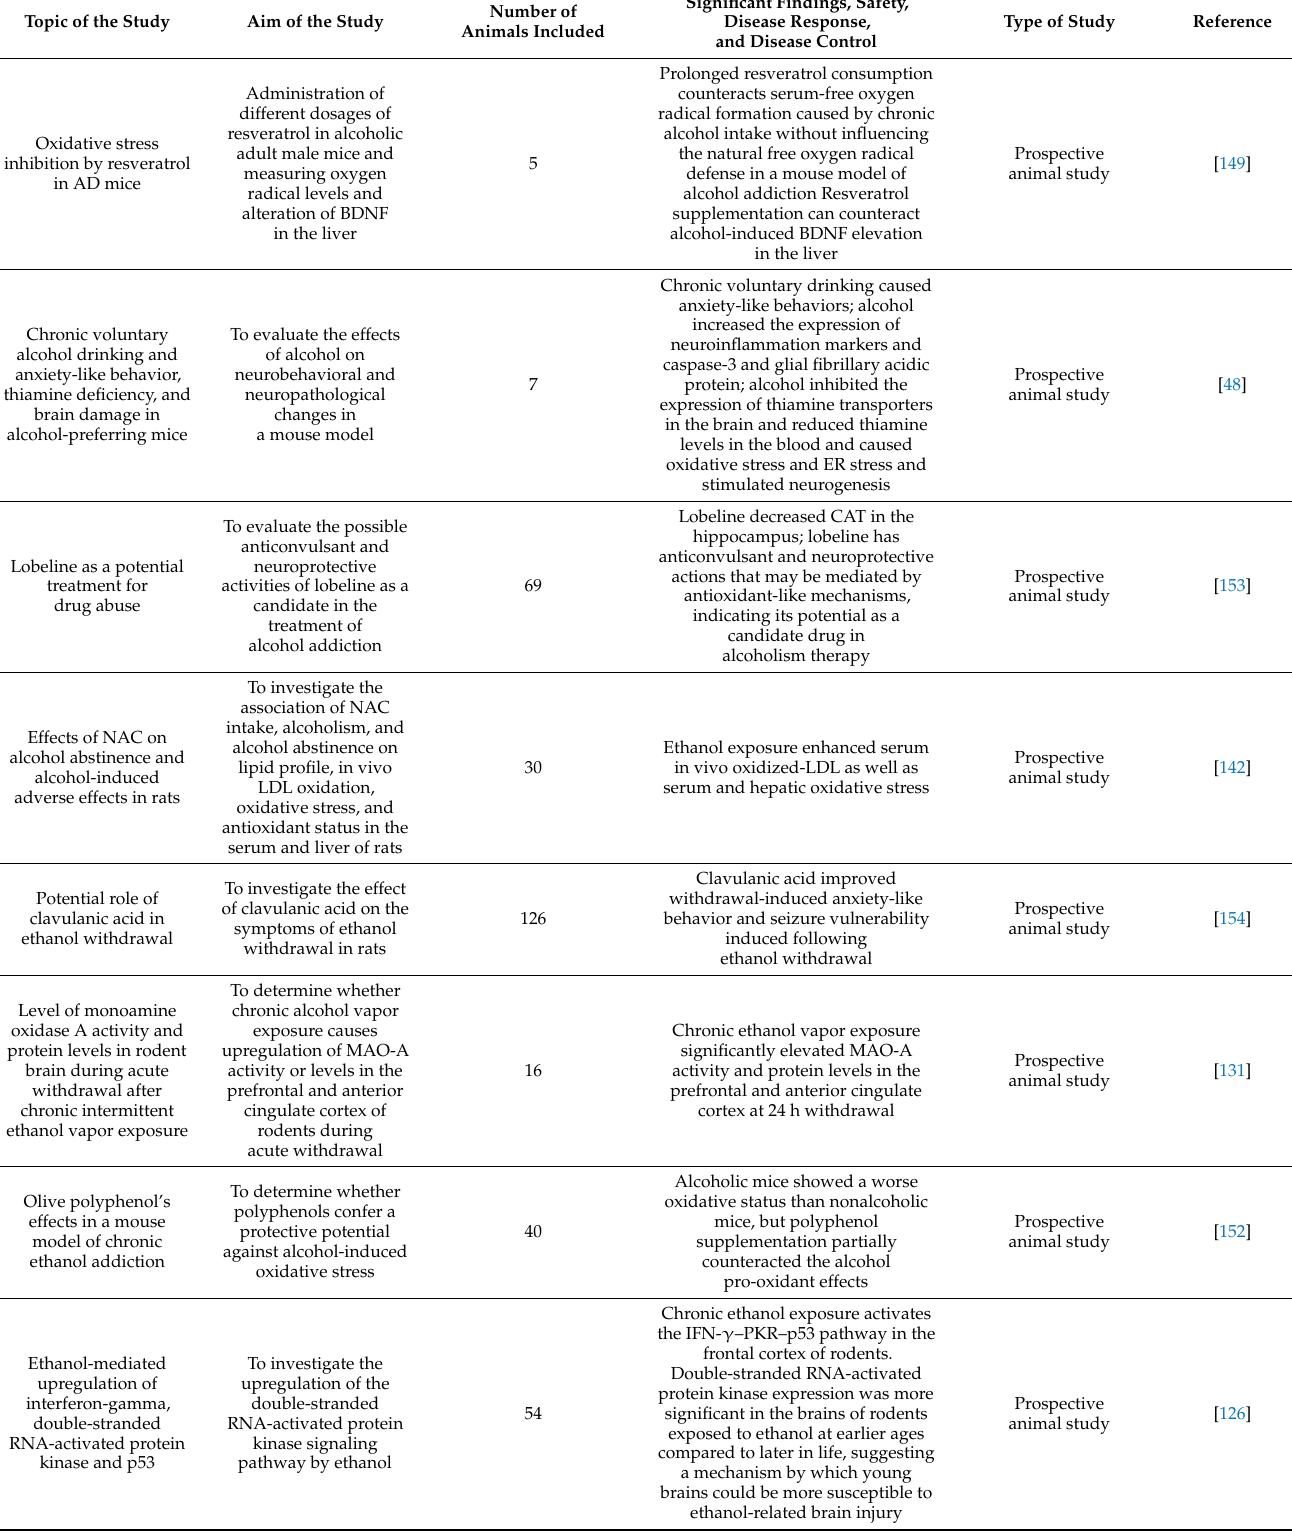
Table 5. Preclinical studies of potential therapeutic agents in animal